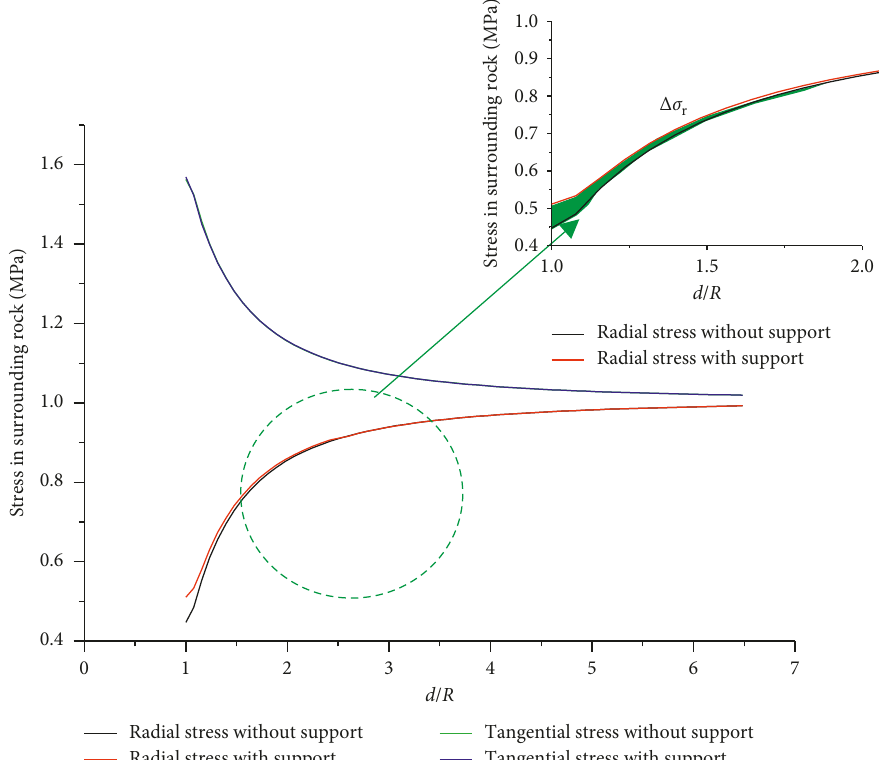
Figure 9: Variation of surrounding rock stress before and after support ( α � 0 .